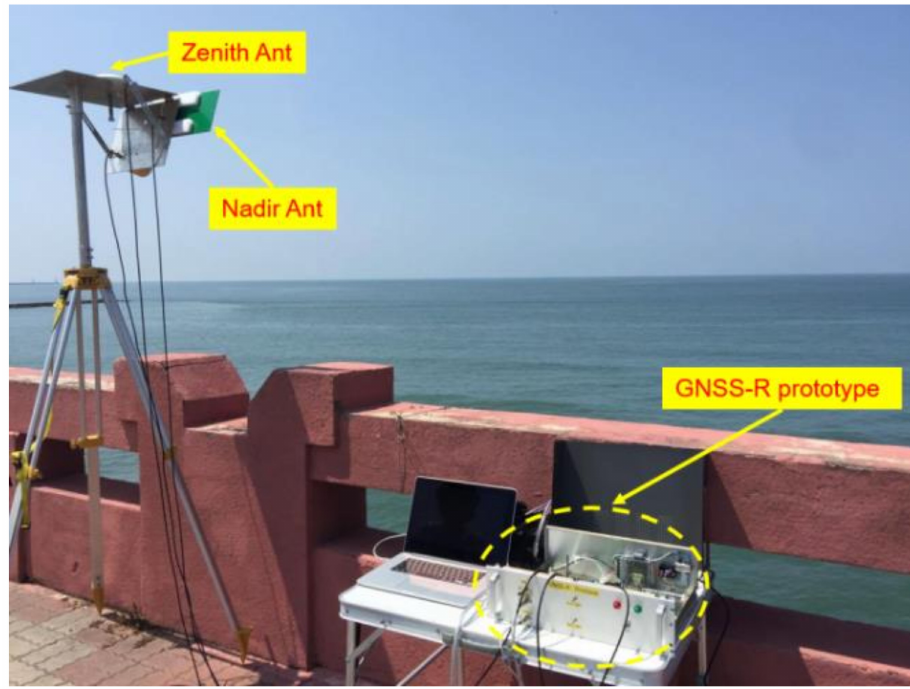
Figure 9. Ground test with the GNSS-R prototype.